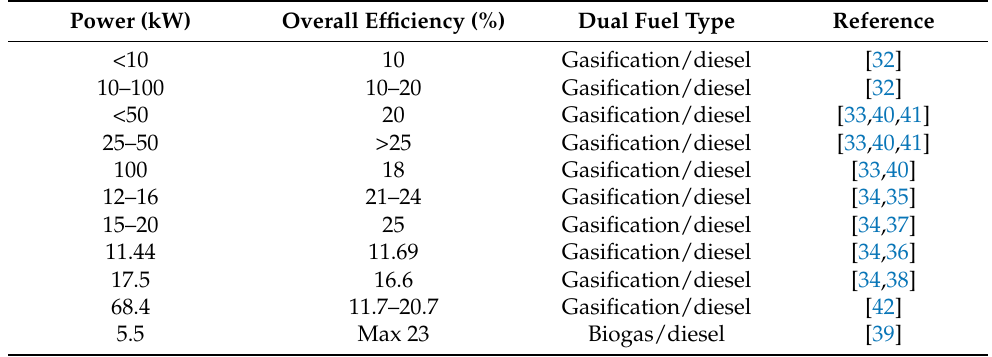
Table 1. Overall efficiency of some dual fuel systems for electricity